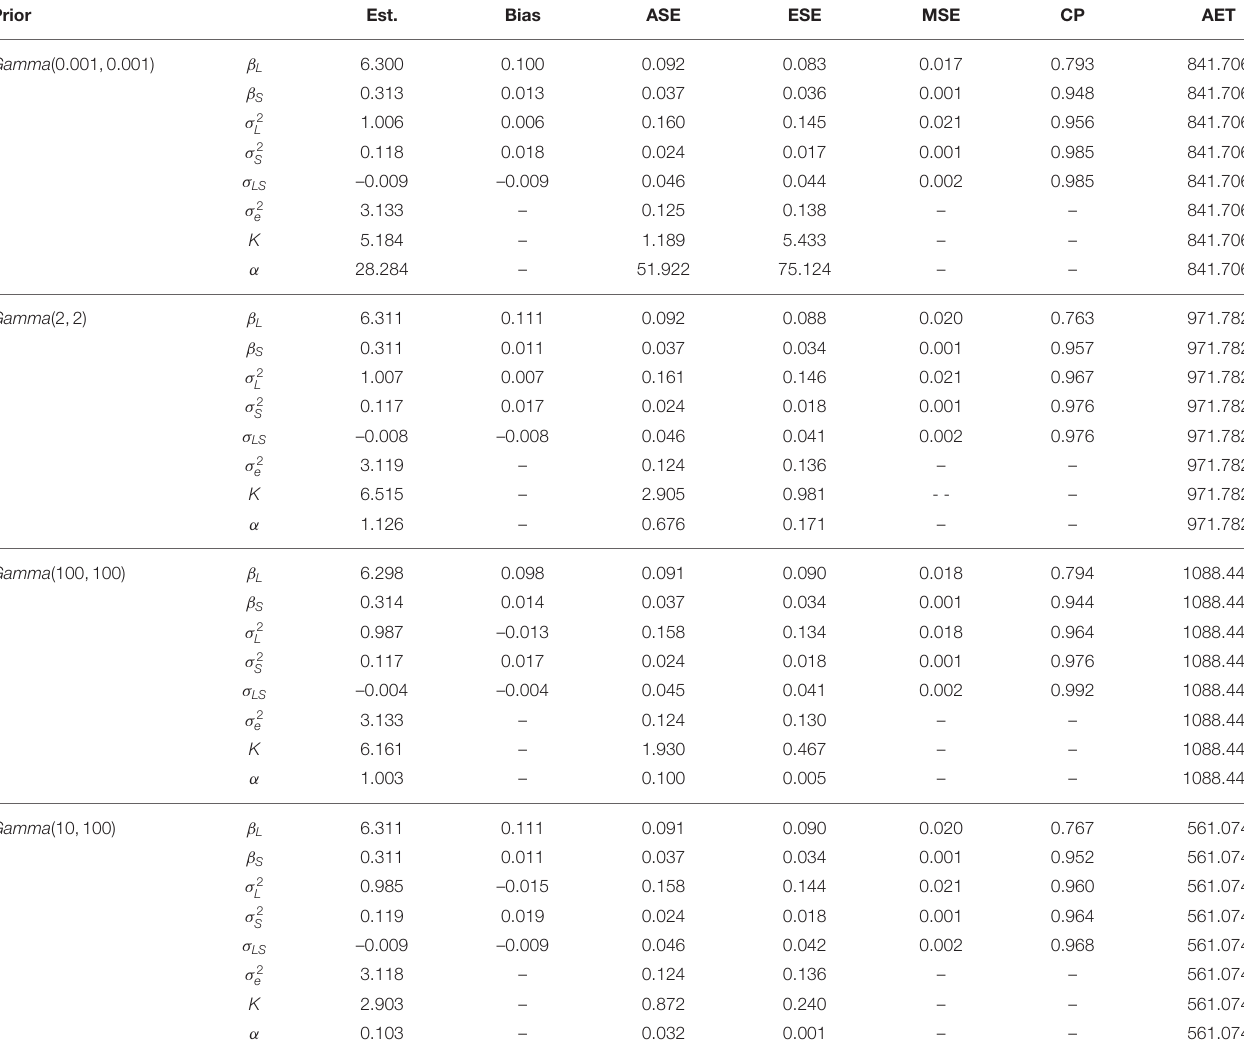
TABLE 3 | Model estimation for BNP growth curve modeling with different precision parameter priors when data contain 5% of outliers and N = 200. Prior Est. Bias ASE ESE MSE CP AET Gamma